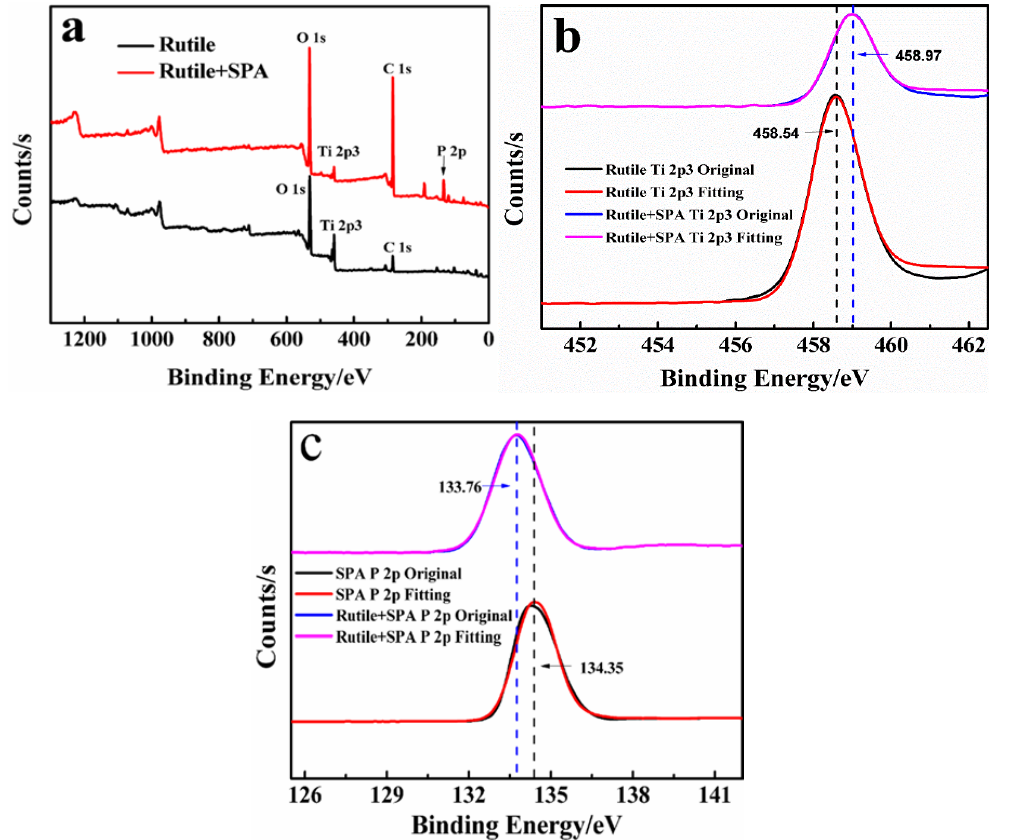
Figure 6. The survey scan and high-resolution X-ray photoelectron spectroscopy (XPS) of rutile before and after SPA adsorption.